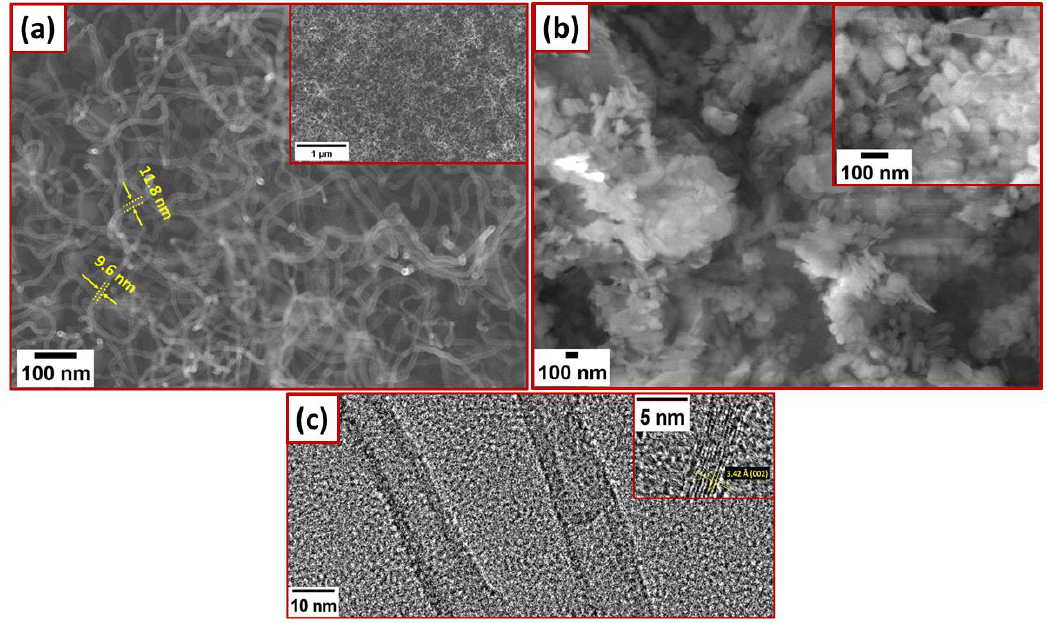
Figure 5. FESEM images of ( a ) MWCNTs grown on Si/SiO 2 substrate and ( b ) BN powder used for the coating on separator. ( c ) TEM image of MWCNTs; the inset shows the HRTEM image of MWCNTs.